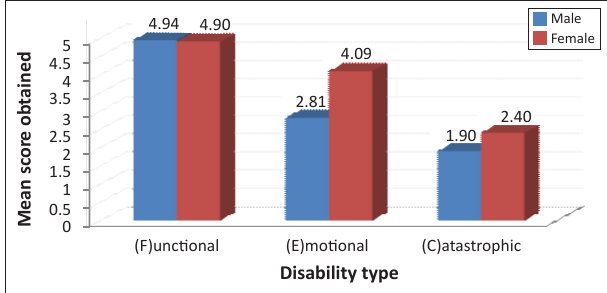
FIGURE 1: Gender comparison of functional, emotional and catastrophic disability in terms of